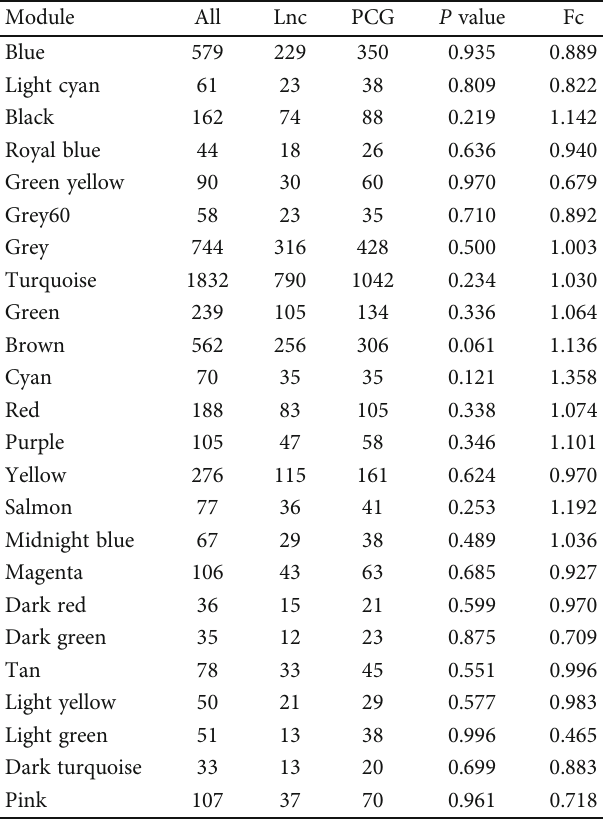
Figure 4: Identi fi cation of co-expression modules based on di ff erentially expressed PCGs and lncRNAs. (a) Cluster analysis on the samples. (b – c) Network topology analysis for di ff erent soft-thresholding powers. (d) Module colors and gene dendrogram. (e) Histogram of relative multiples of lncRNA ratio to PCG ratio in 23 modules. The horizontal axis is the multiple of the lncRNA ratio to the PCG ratio in the module, vertical axis is module, and the values on the right are signi fi cant P values. (f) Correlation between 24 modules and clinical phenotype. Table 3: PCGs and lncRNA in